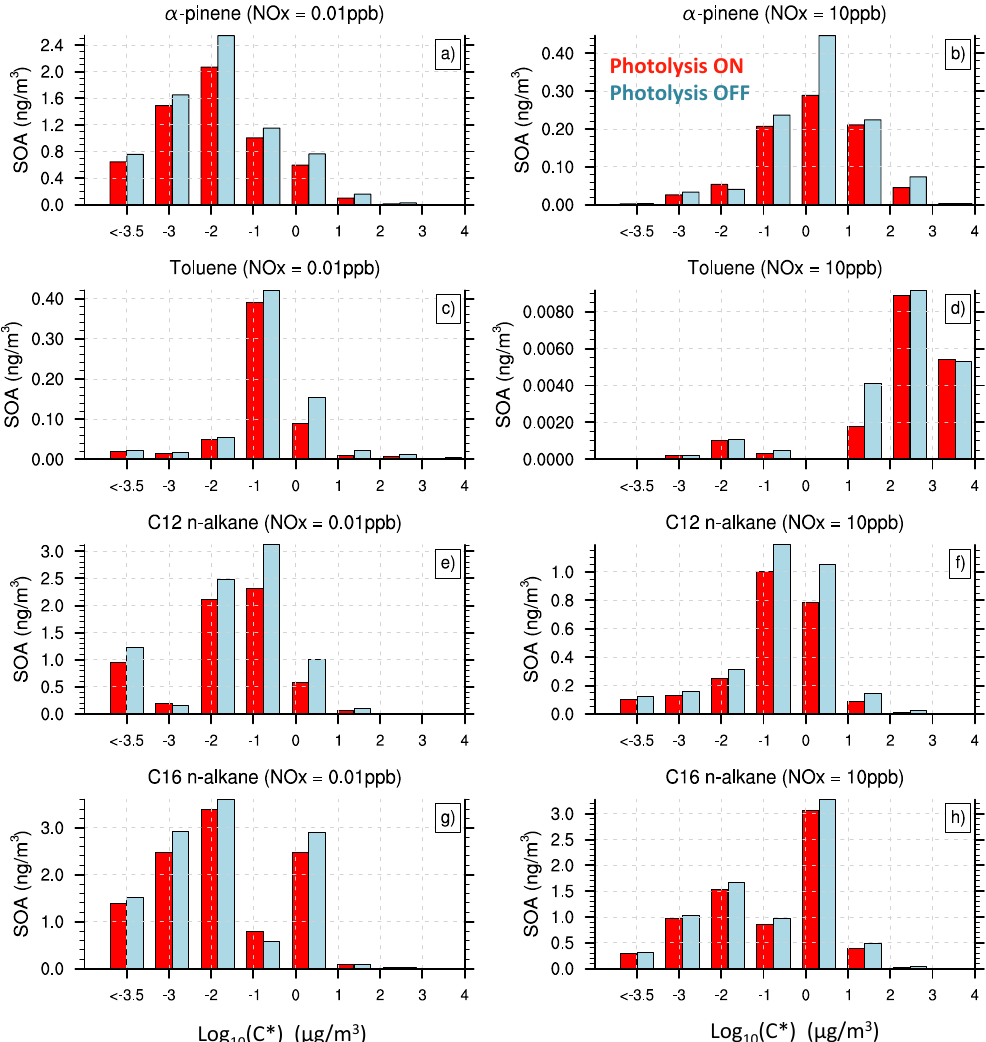
Figure 4. Distribution of products of OH oxidation of 1ppt of α -pinene, toluene, and C 12 and C 16 n -alkanes at low (0.01ppb) and high (10ppb) NO x levels according to their volatility. The volatility is expressed in terms of the effective saturation concentration ( C ∗ ). Predictions represent values at the maximum SOA yield based on the BASE case simulation with (red) and without (blue) gas-phase photolysis of